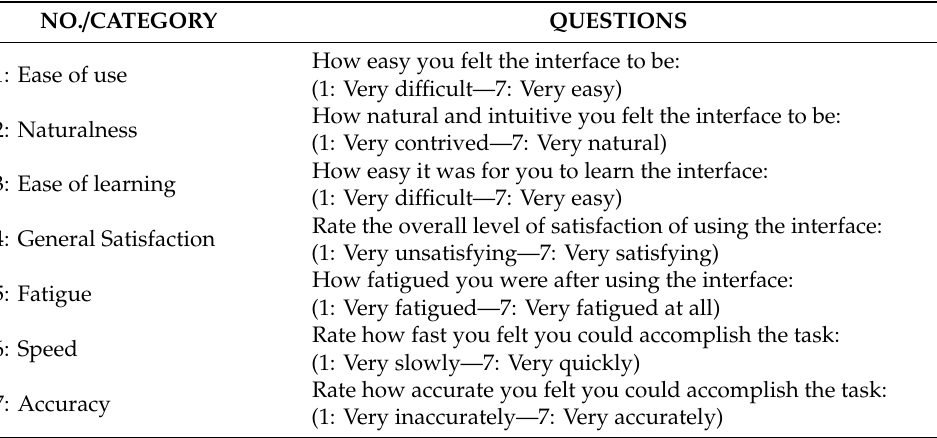
Table 1. The general usability survey